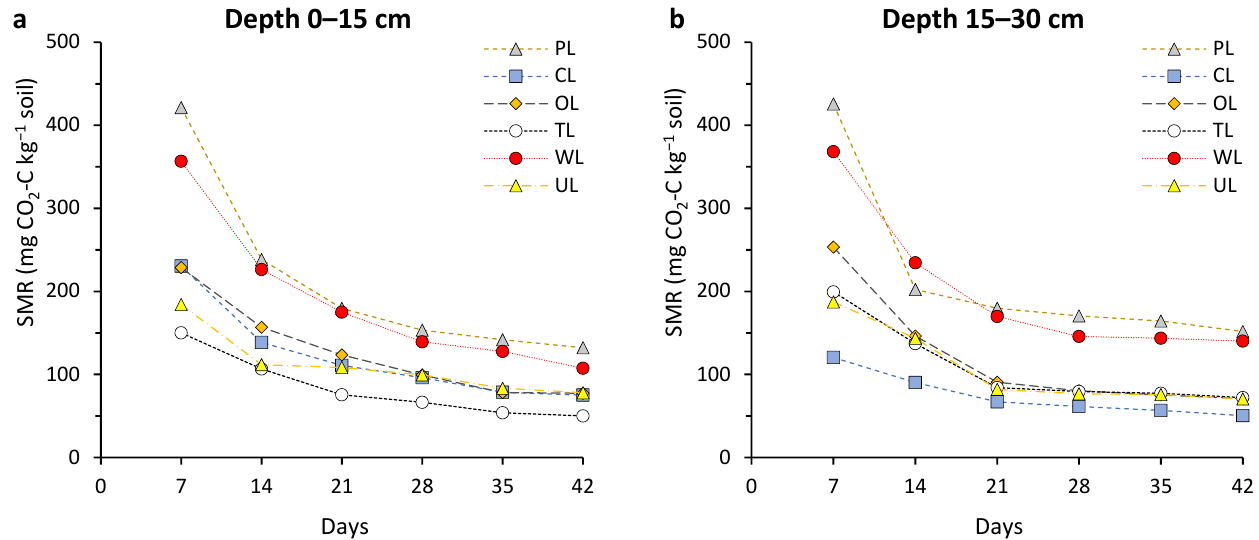
Figure 1. Changes in soil microbial respiration (SMR) during the incubation period (42 days) affected by different land uses and in two soil depths: ( a ) 0–15 cm, and ( b ) 15–30 cm. PL: pastureland; CL: cropland; OL: orchard land; TL: tea land; WL: woodland; UL: uncultivated land.